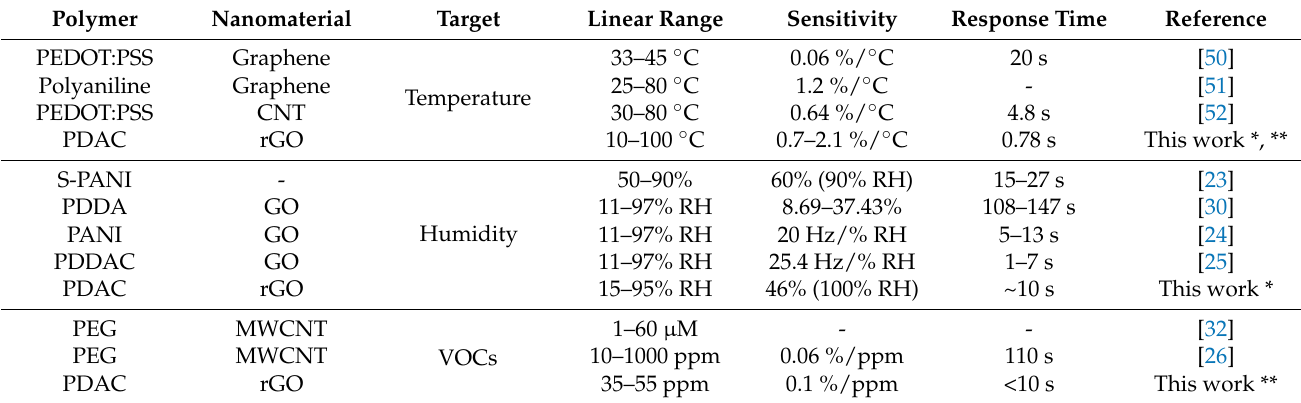
Table 1. The performance comparison of previously reported LbL-manufactured sensors and those reported in this work (RH—relative humidity). For this comparison, the sensors with carbon-based nanomaterials were considered.